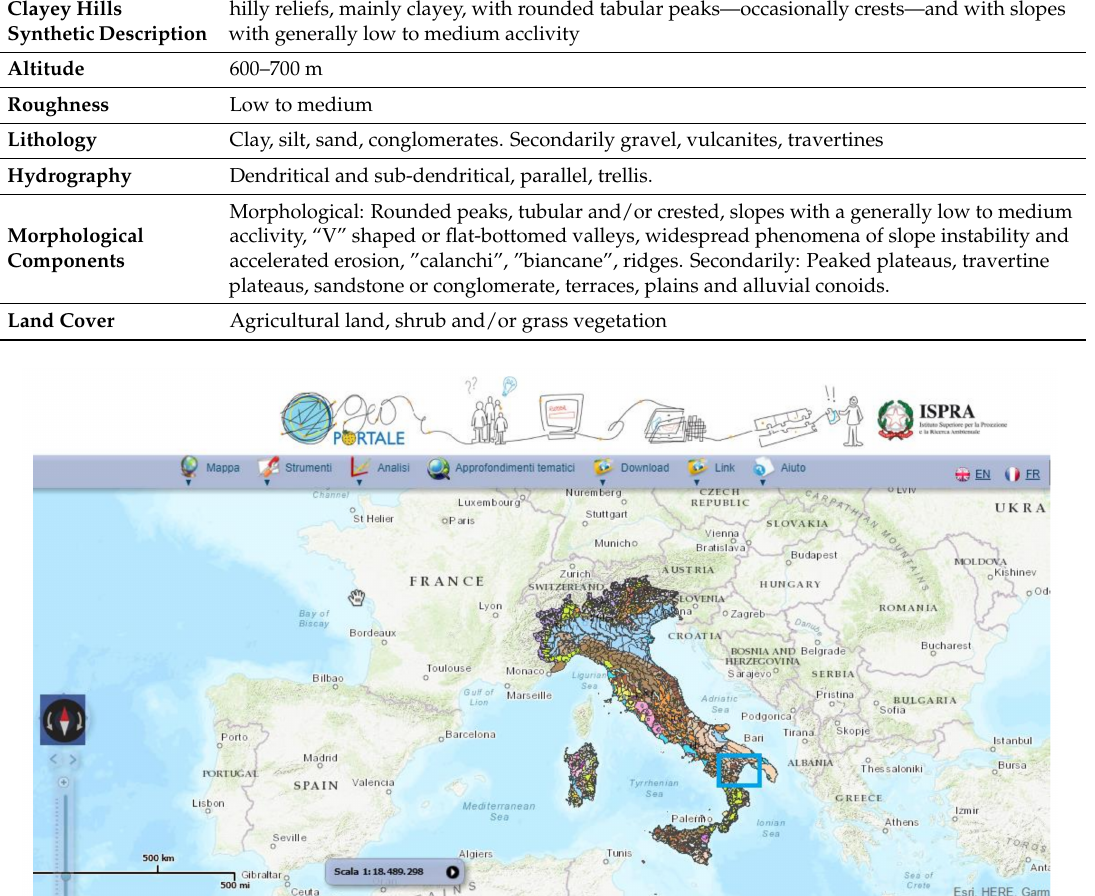
Table 1. Information related to the landscape type where the “Calanchi” are located.